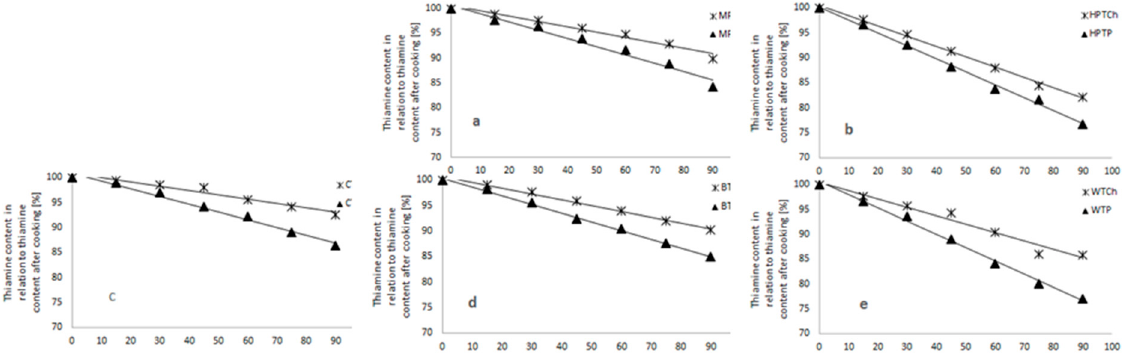
Figure 3. Thiamine content [%] in gnocchi dumplings with thiamine hydrochloride—TCh and thiamine pyrophosphate—TP carriers: ( a )-Muscat Pumpkin (MP), ( b )-Hokkaido Pumpkin (HP), ( c )-Cauliflower (C), ( d )-Broccoli (B) and ( e )-without carriers, during frozen storage. The 100% of thiamine content corresponds to the after-cooking thiamine content. Table 2. Dynamics of changes in thiamine content (mg TCh or TP kg − 1 ) in gnocchi dumplings with TCh and TP carriers: Muscat Pumpkin, Hokkaido Pumpkin, Cauliflower, Broccoli during frozen storage shown as values of half time of thiamine degradation (T 1/2 ) and coefficients in regression equations.